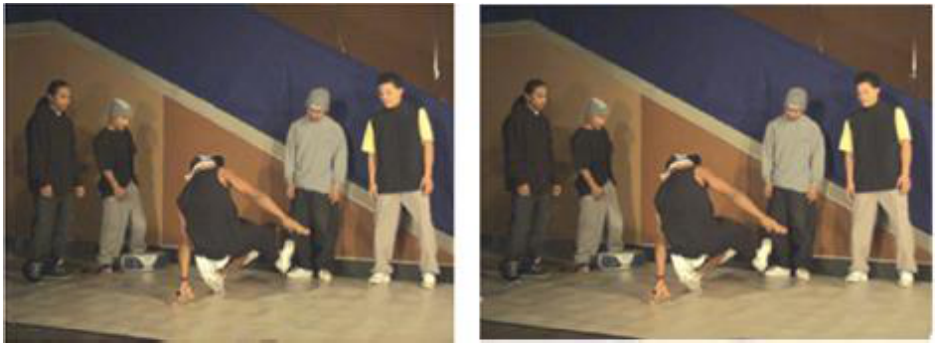
Figure 7: Yang method, the proposed method and the effect of amplifying the original image of the three comparison